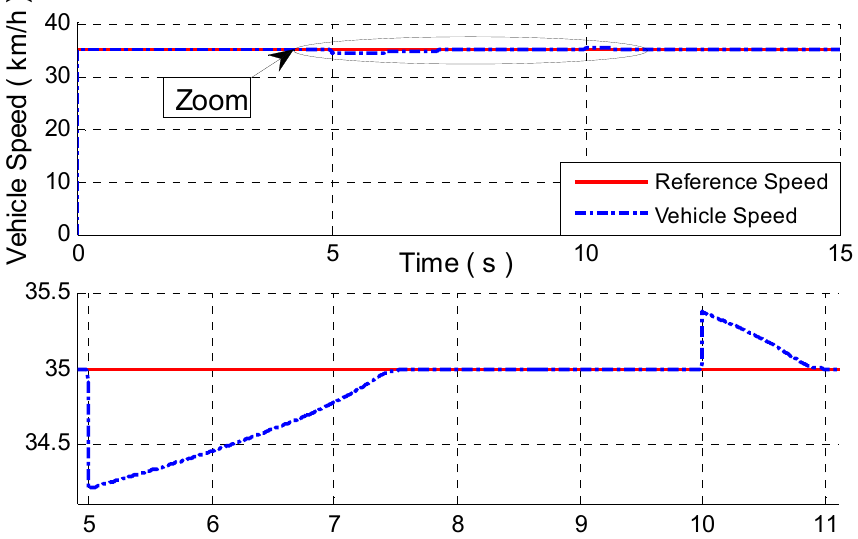
Figure 16. Vehicle speed and its reference with zoom.